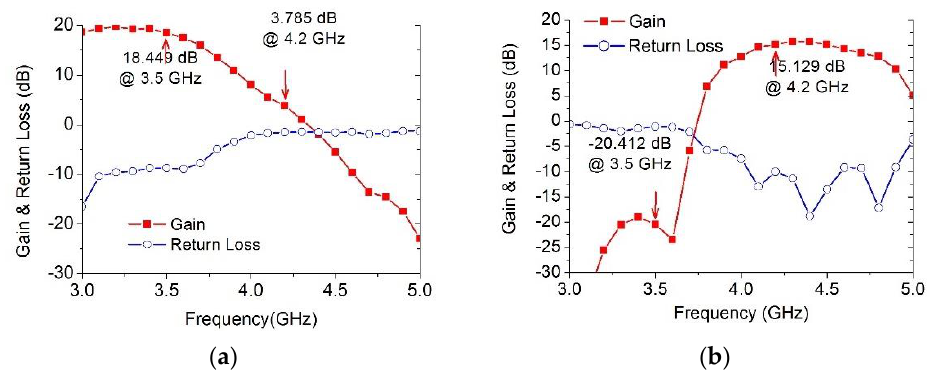
Figure 9. Measurement results of the BPF and LNA for the 3.5 GHz and 4.2 GHz signal paths. ( a ) Results of the gain and isolation at 3.5 GHz when transmitting a 4.2 GHz signal (20.0 dB for gain, 14.8 dB for isolation) ( b ) Results of the gain and isolation at 4.2 GHz when transmitting a 3.5 GHz signal (17.1 dB for gain, 35.5 dB for isolation).